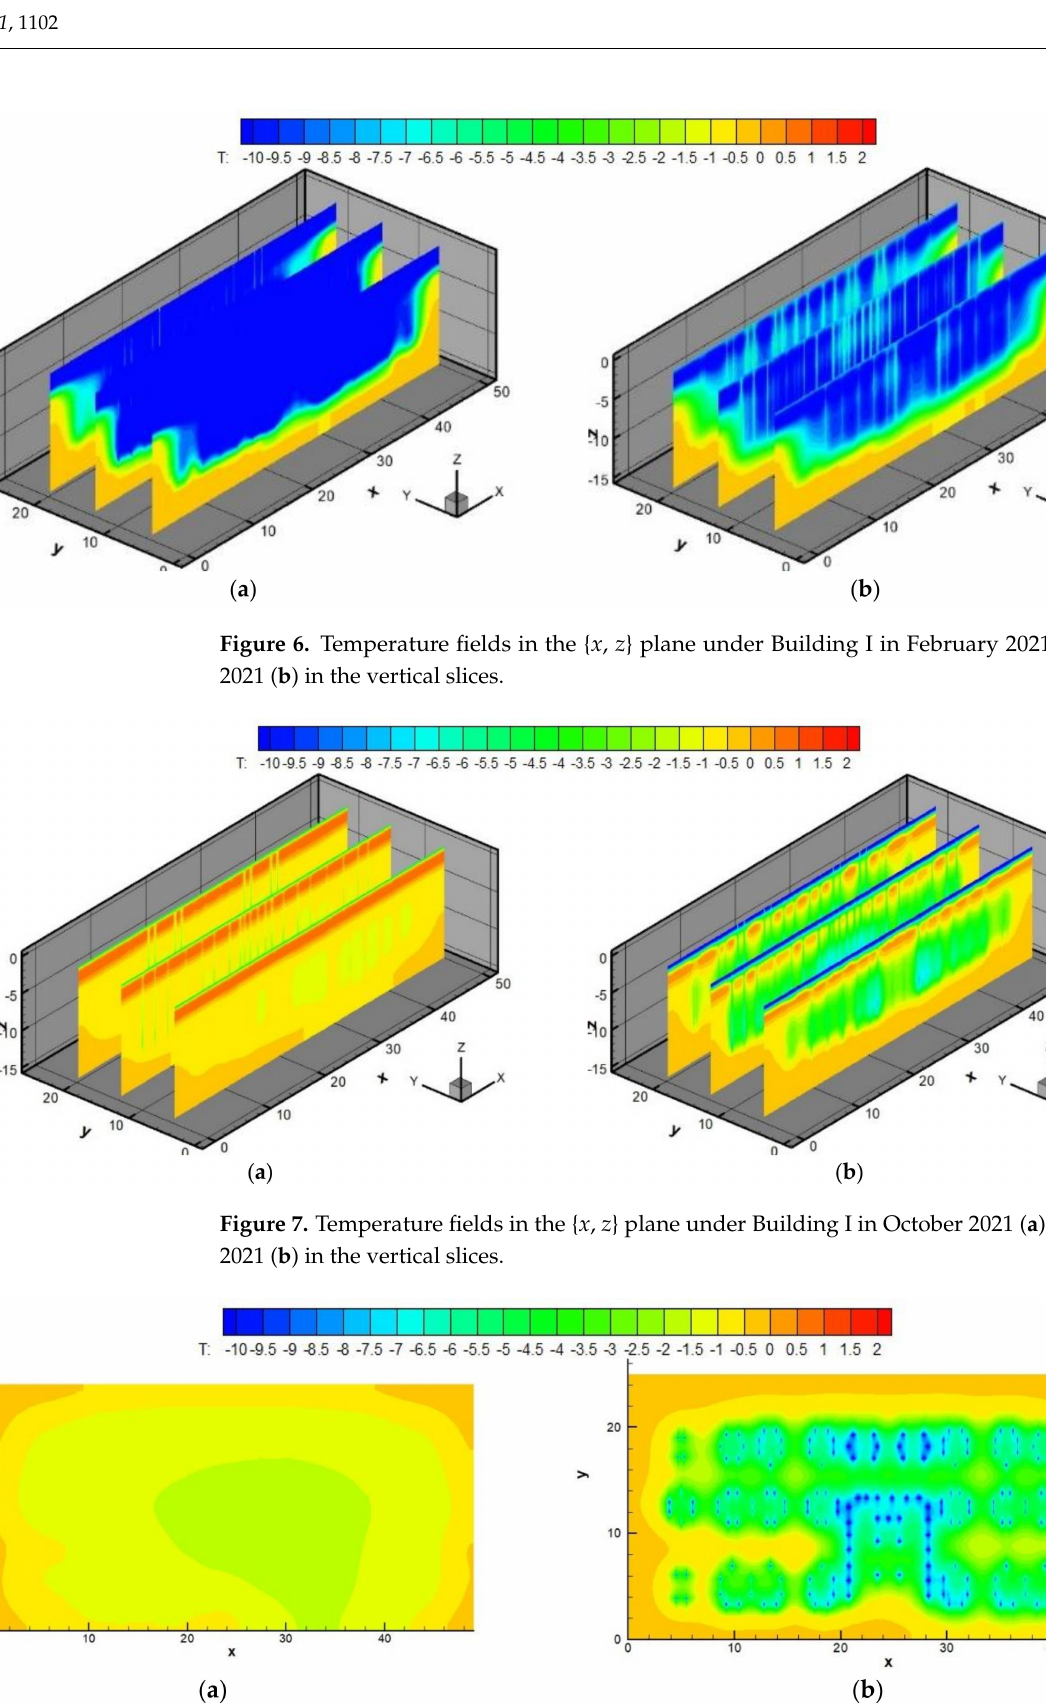
Figure 8. Temperature field at the depth of 2.3 m under Building I in September 2021 ( a ) and November 2021 ( b ) in the { x , y }